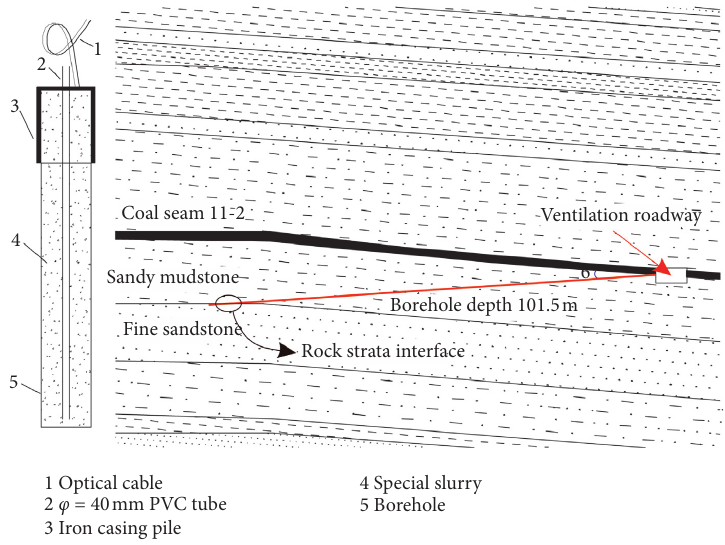
Figure 1: Installation and arrangement of the optical fiber test